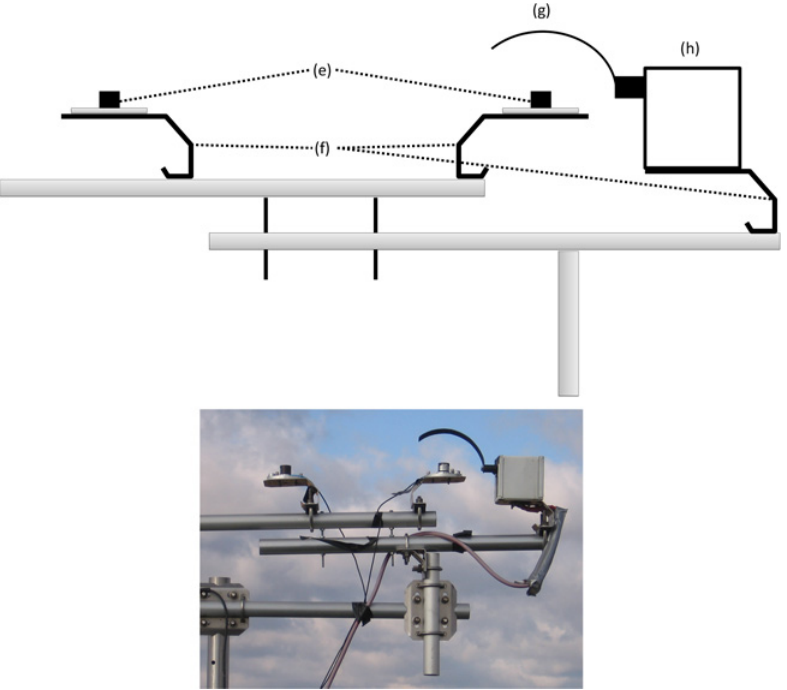
Figure 3. Side view zoom of shadowband apparatus design (not to scale). Components listed in Table 2.